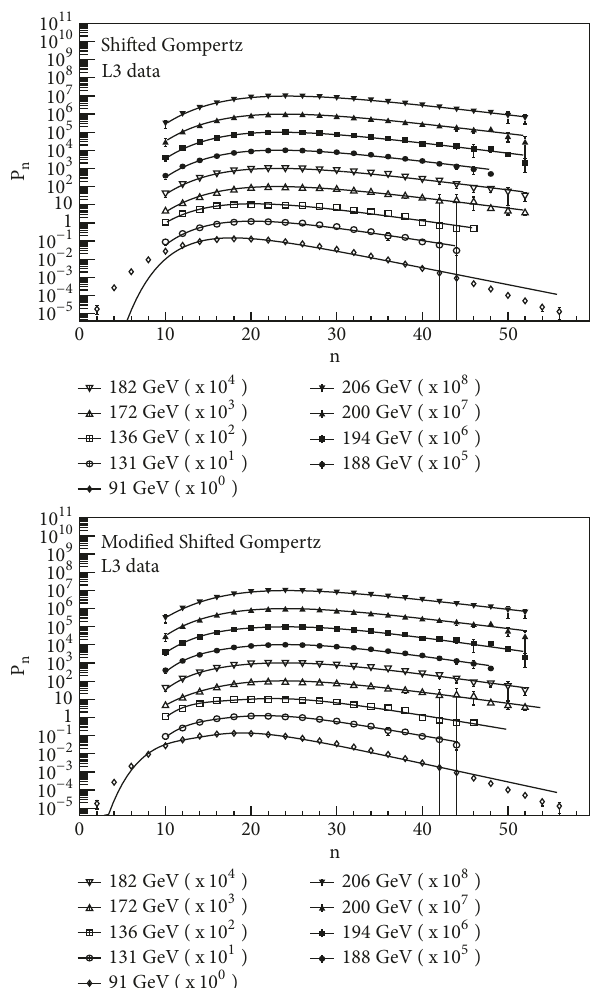
Figure 1: Charged multiplicity distributions from L3 experiment. Solid lines represent the Gompertz distributions.